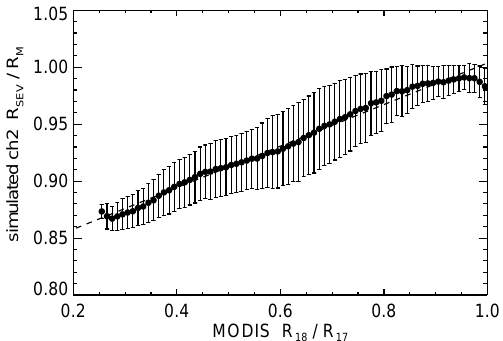
Fig. 2. Relation between simulated SEVIRI to MODIS reflectance ratio in channel 2 (0.8µm) and MODIS ch18/ch17 reflectance ra- tio, demonstrating the water vapour correction capability in our SRF correction procedure. Circles show the mean and vertical bars the standard deviation of simulated ch2 reflectance ratio in a MODIS ch18/ch17 reflectance ratio bin. The figure is based on about 200000 data points from the year 2008. The correlation coef- ficient of the underlying individual data points is